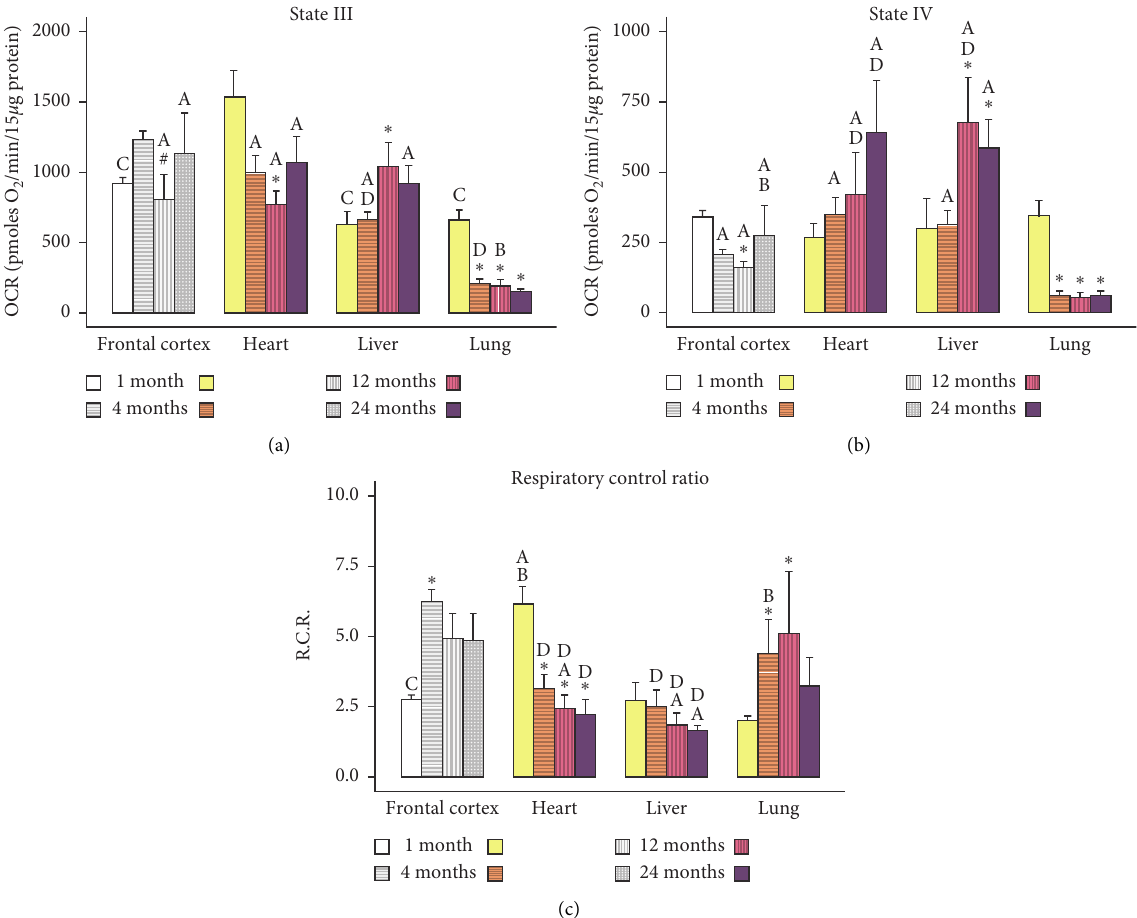
Figure 1: Age-dependent changes in State III (a) and State IV respiration (b) rates and respiratory control ratio (c) in different organs. Values are expressed as means ± SEM from n � 5-6 observations/group. The differences between pairwise comparisons were considered statistically significant at p < 0 . 05. ∗ Significantly different from 1M rats; # significantly different from 4M rats; A significantly different from lung; B significantly different from liver; C significantly different from heart; D significantly different from frontal cortex; SEM, standard error of the mean. Grey-scale textured bars represent frontal cortex data from our previous report (adapted from Pandya et al. [23], with